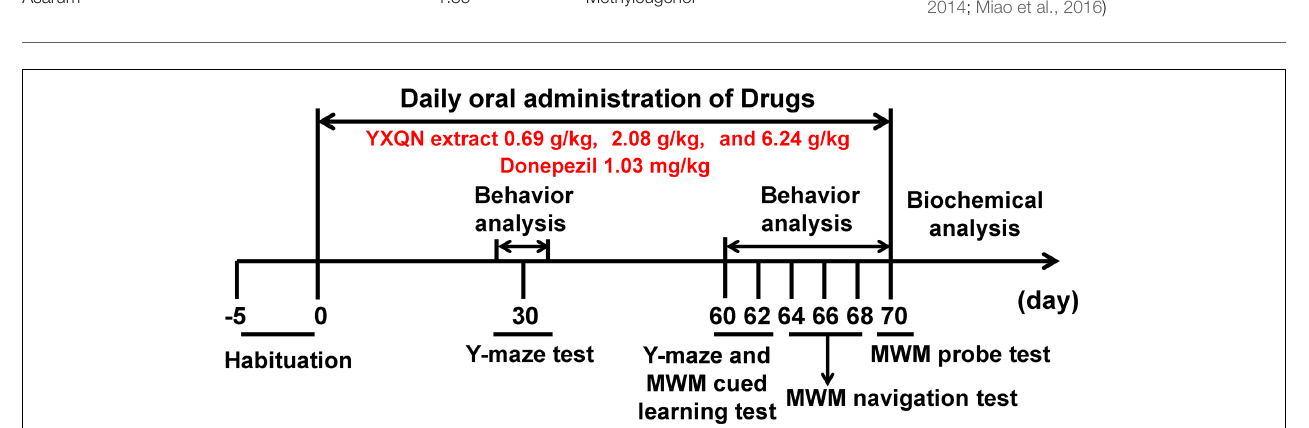
FIGURE 1 | Behavior and biochemical analysis schedule to study the effects of YXQN on APP/PS1 mice.